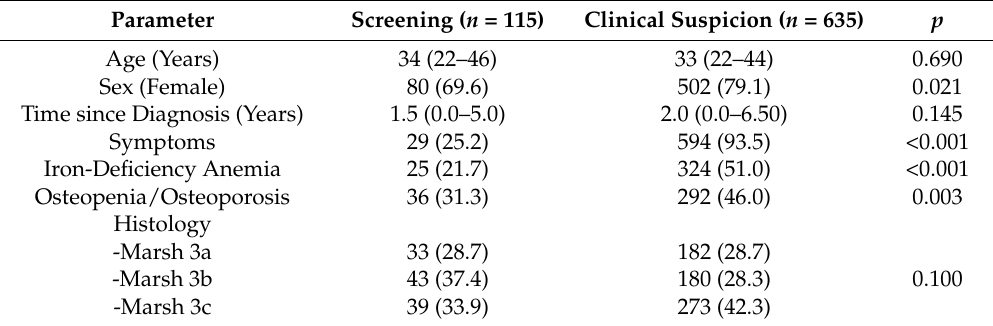
Table 2. Characteristics of screening- and clinically detected patients.